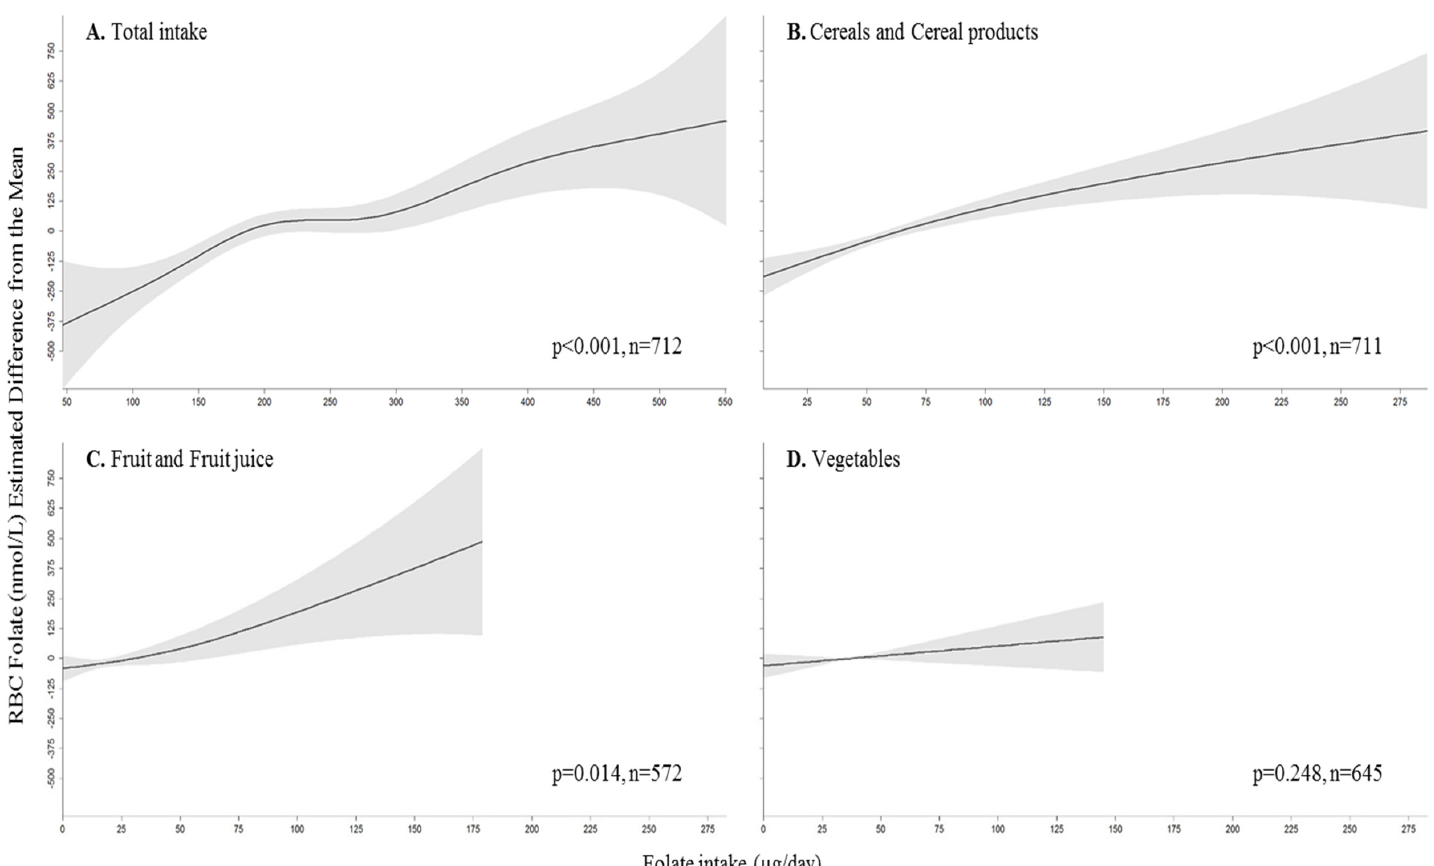
Figure 1. Estimated difference from the mean (and 95% CI) of RBC folate concentration according to folate intake from A. all dietary sources, B. from cereals and cereal products, C. from fruit and fruit juice and D. from vegetables. Generalized additive model (gam) adjusted for sex, energy intake, MTHFR genotype, folic acid supplement use and folate intake from the two other food sources. The highest 2.5th percentiles of RBC folate concentrations are not included. Three participants with a folate intake above 150 μ g only from vegetables were not included. One participant with a folate intake of 327 μ g only from fruit and fruit juice was excluded. p values are from the corresponding gam model.